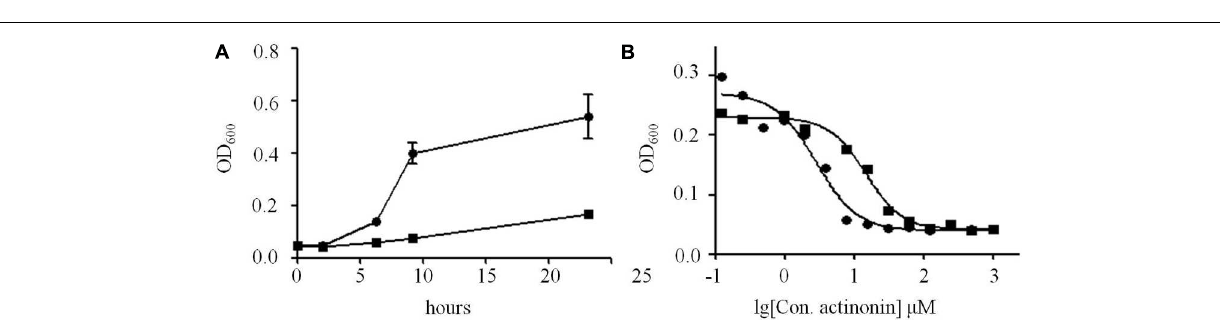
FIGURE 4 | Characterization of marine derived actinonin. (A) Structure of actinonin isolated from Streptomyces sp. NHF165. (B) Anti- V. anguillarum IC 50 value of actinonin. (C) Anti-VaPDF IC 50 value of actinonin.